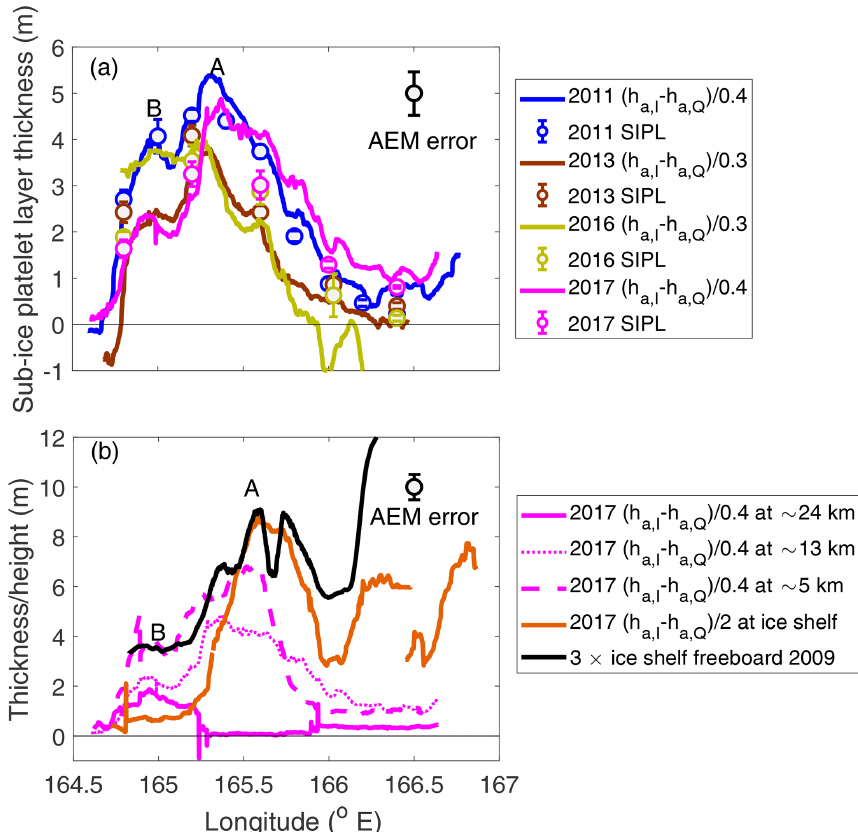
Figure 10. (a) SIPL thickness along 77 ◦ 46 (cid:48) S in 2011, 2013, 2016, and 2017, approximately 11km from McMurdo Ice Shelf front. Recurring local maxima or shoulders in thickness are identified at A and B. (b) SIPL thickness profiles in November 2017 at different distances from McMurdo Ice Shelf front (pink lines), at approximately 24km (solid), 13km (dotted), and 5km (dashed). The figure also shows uncalibrated, scaled SIPL thickness beneath the ice shelf in 2017 (brown) and scaled ice shelf freeboard in 2009 (black; from Rack et al., 2013), at 77 ◦ 55 (cid:48) S. The ice shelf data are smoothed by a moving-average filter of window size 50. Local thickness maxima are identified at A and B. The data reduction model uncertainty in AEM total thicknesses (snow + ice + SIPL) is